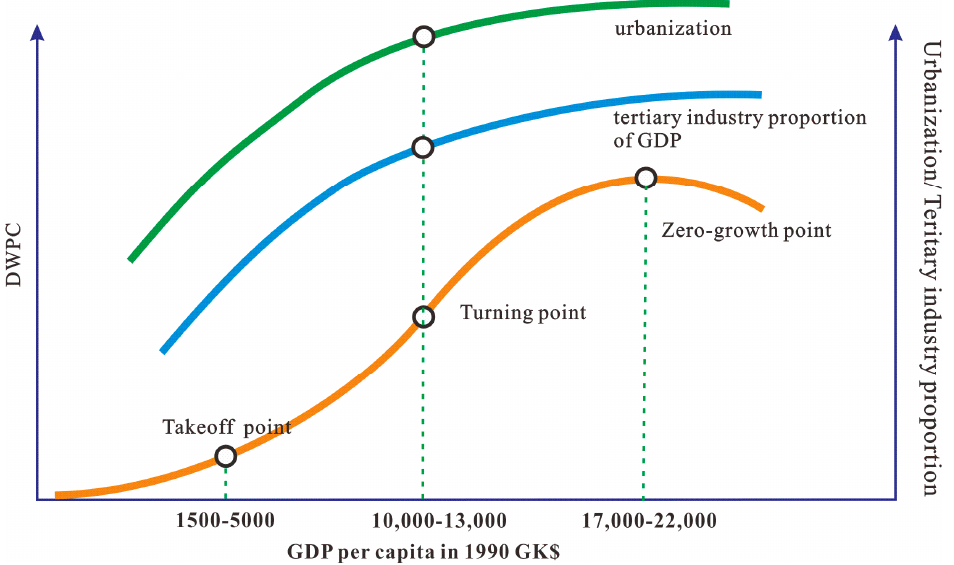
Figure 7. Relationship between key points of expanded S-curve and important indicators of economic and social development.